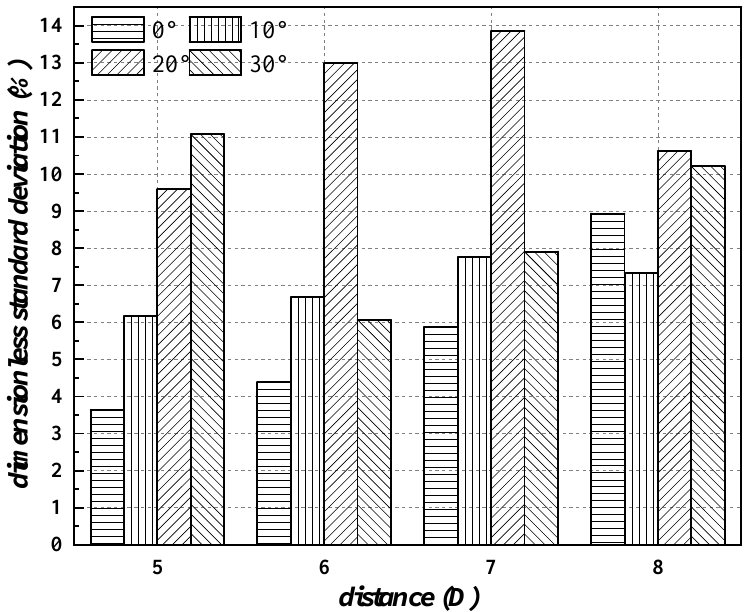
Figure 8. Standard deviations of the power fluctuation of WT2 under various working conditions.